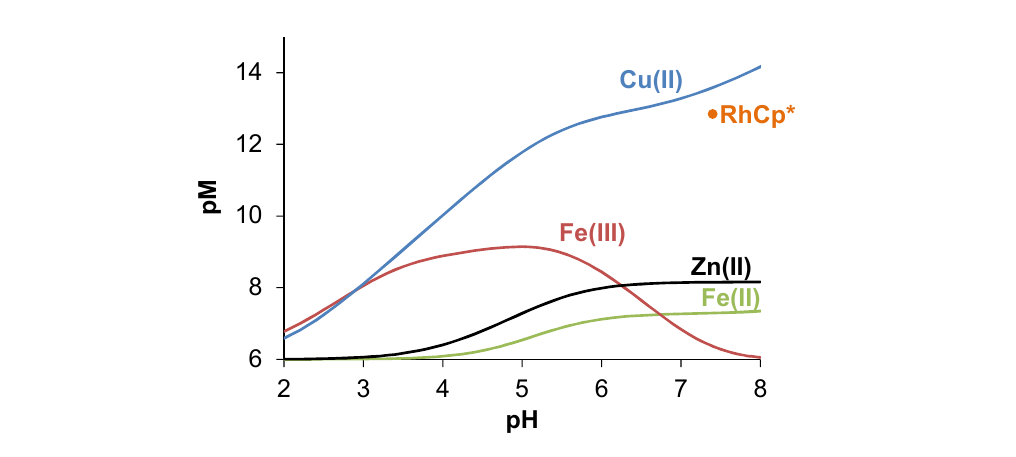
Figure 7. pM values calculated on the basis of the determined stability constants (Table 2) plotted against the pH. pM = −log ([M]+[M i (OH) j ]) (Fe(III): i, j = 1, 1; i, j = 1, 2; i, j = 2, 2; i, j = 3, 4; Fe(II): i, j = 1, 1; i, j = 1, 2; i, j = 1, 3) represents the unbound metal fraction under the given conditions. The value computed for the RhCp* complex is also shown at pH 7.4 (see the conditional stability constant in Section 2.4). { c ligand = 10 μM; c M = 1 μM; I = 0.10 M KCl; t = 25.0 °C}.